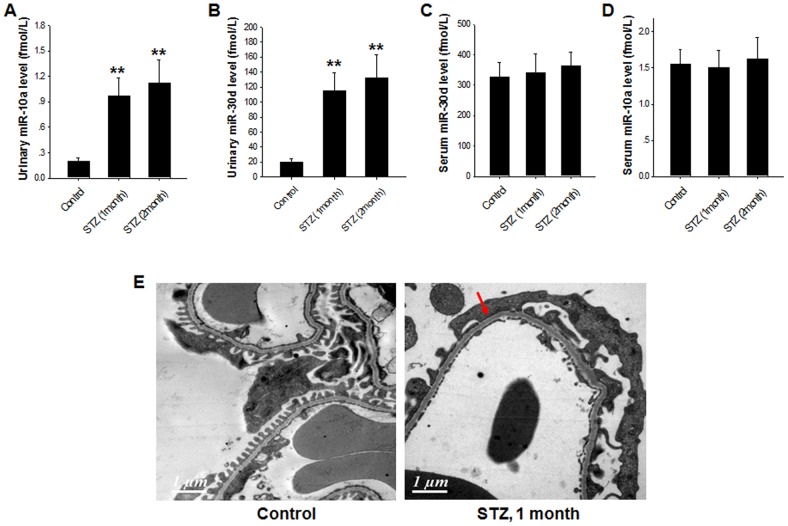
Elevation of the urinary miR-10a and miR-30d levels but not serum miR-10a and miR-30d in mice with STZ diabetes-associated kidney injury.Note that the levels of urinary miR-10a (A) and miR-30d (B) were significantly increased in mice with STZ diabetes-induced kidney injury, whereas the levels of serum miR-10a (C) and miR-30d (D) were not altered. E, a represented image of electron microscopy showing that mice with 1 month STZ treatment have segmental podocyte foot process effacement (arrow). The data are presented as means ± SEM for six independent experiments; three mice were used in each experiment. *, p<0.05.